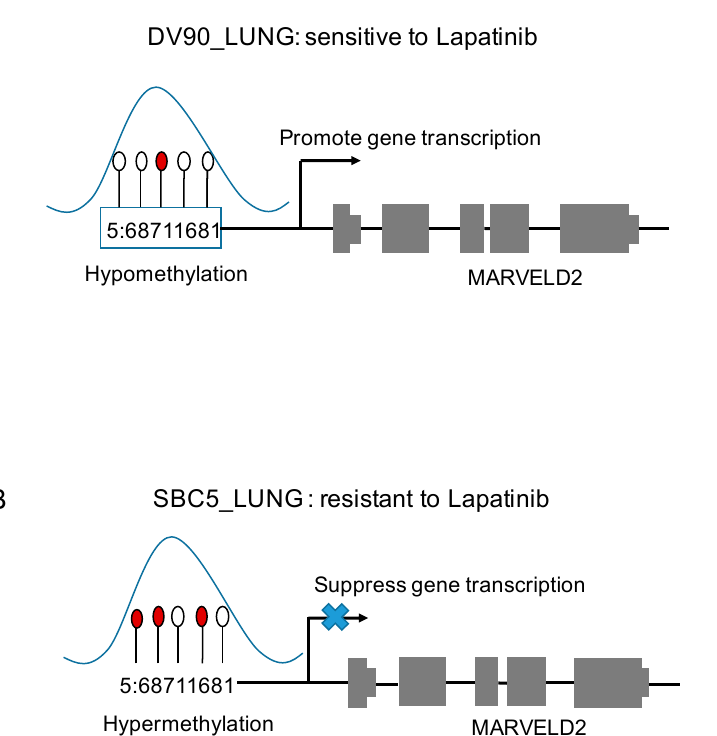
Figure 6. Results of difference analysis. ( A ) The violin plot shows the absolute value of logFC and − log10( p value) for each EGFR inhibitor. ( B ) The number of absolute value of logFC > 0.5 and the p value < 0.05 for each EGFR inhibitor.